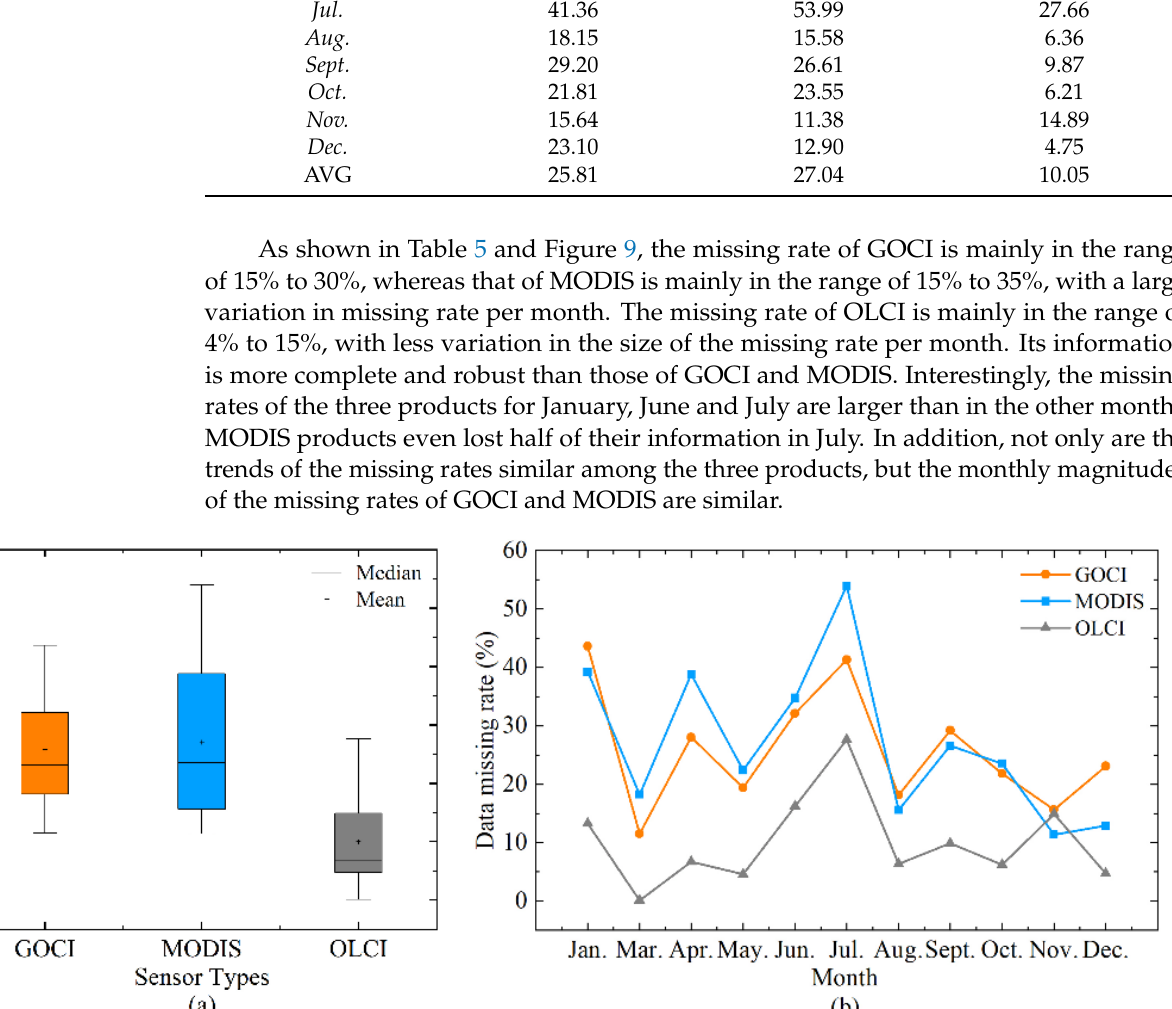
Figure 9. Diagram of month-by-month missing rate: ( a ) box line diagram and ( b ) line graph. With respect to the completeness of data, the information was judged based on the average annual missing rate indicator only. The quality of OLCI is better than the other two product data, followed by that of GOCI, whereas MODIS has the lowest quality. However, the three data missing rates are large, and the monthly missing rates of GOCI and MODIS products are similar to the inter-annual variations. The remote sensing information corresponding to the spatial location of Level 1 data in the product data-free area is complex. A single missing rate indicator cannot accurately describe the quality of the GOCI and MODIS products. Therefore, the remote sensing information of the products’ data-free areas was mined to further obtain the missing information and improve the quality evaluation of the ocean color products. Level 1 data were mined for spectral information by using ISAM. The composition and distribution of the main marine objects in the product data-free area are shown in Table 6.